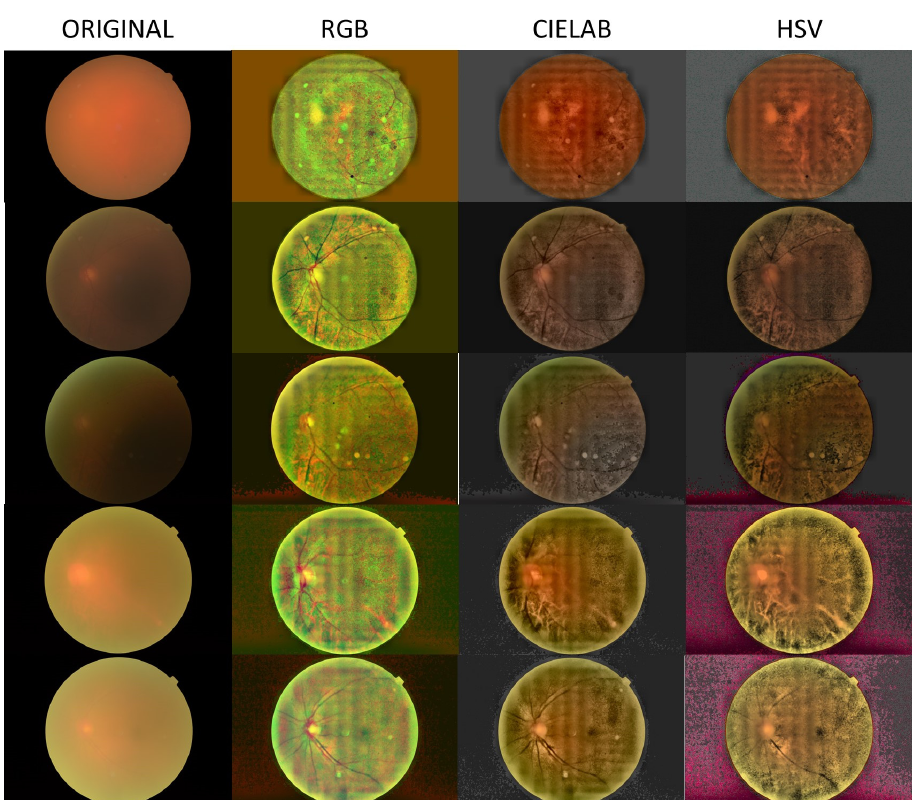
Figure 4. Processed images for the case of severe cataract.